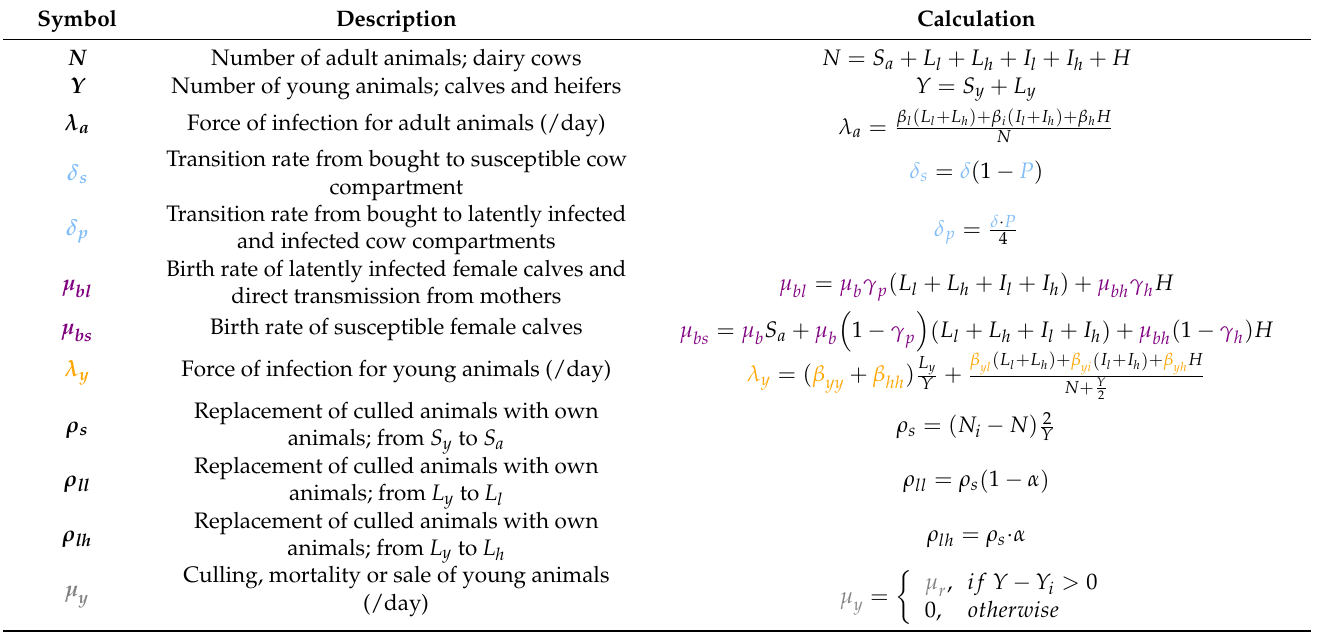
Table 2. Calculation of parameters or transitions in the model for the spread of Mycobacterium avium subsp. paratuberculosis in a typical Slovenian dairy